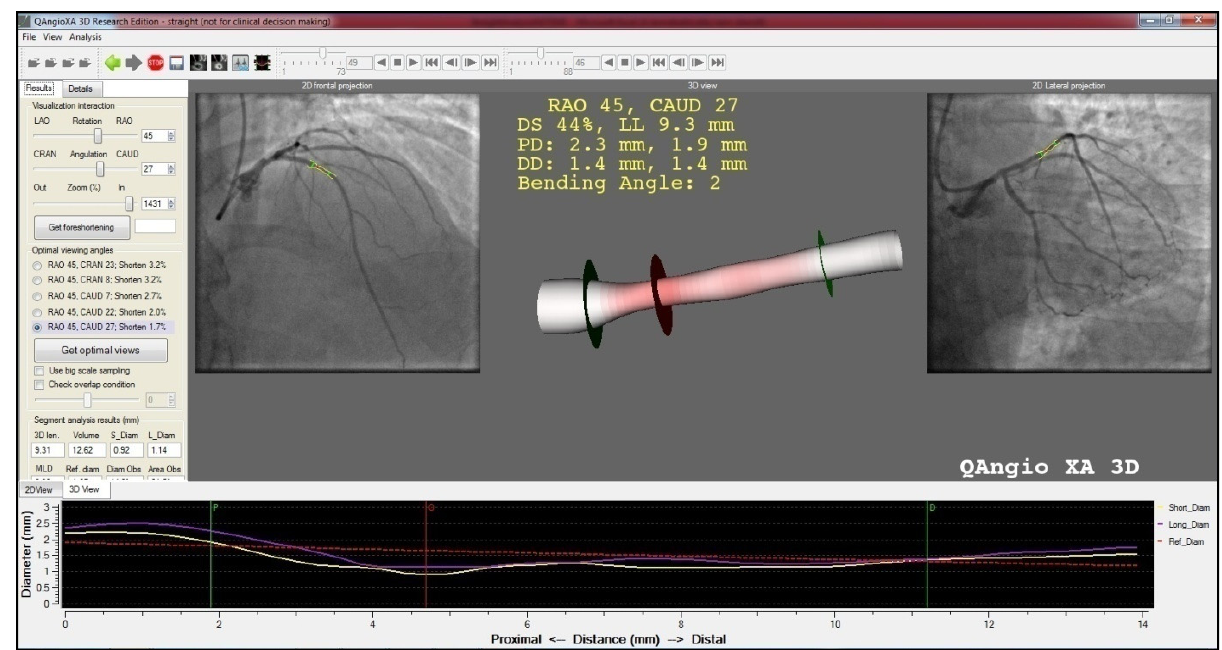
Figure 1. 2D/3D reconstruction image of the plaque and the involved coronary segment with the use of QAngioXA 3D. The left and right discs represent the starting and end point of reconstruction, whereas the middle disc shows the narrowest point of the segment .